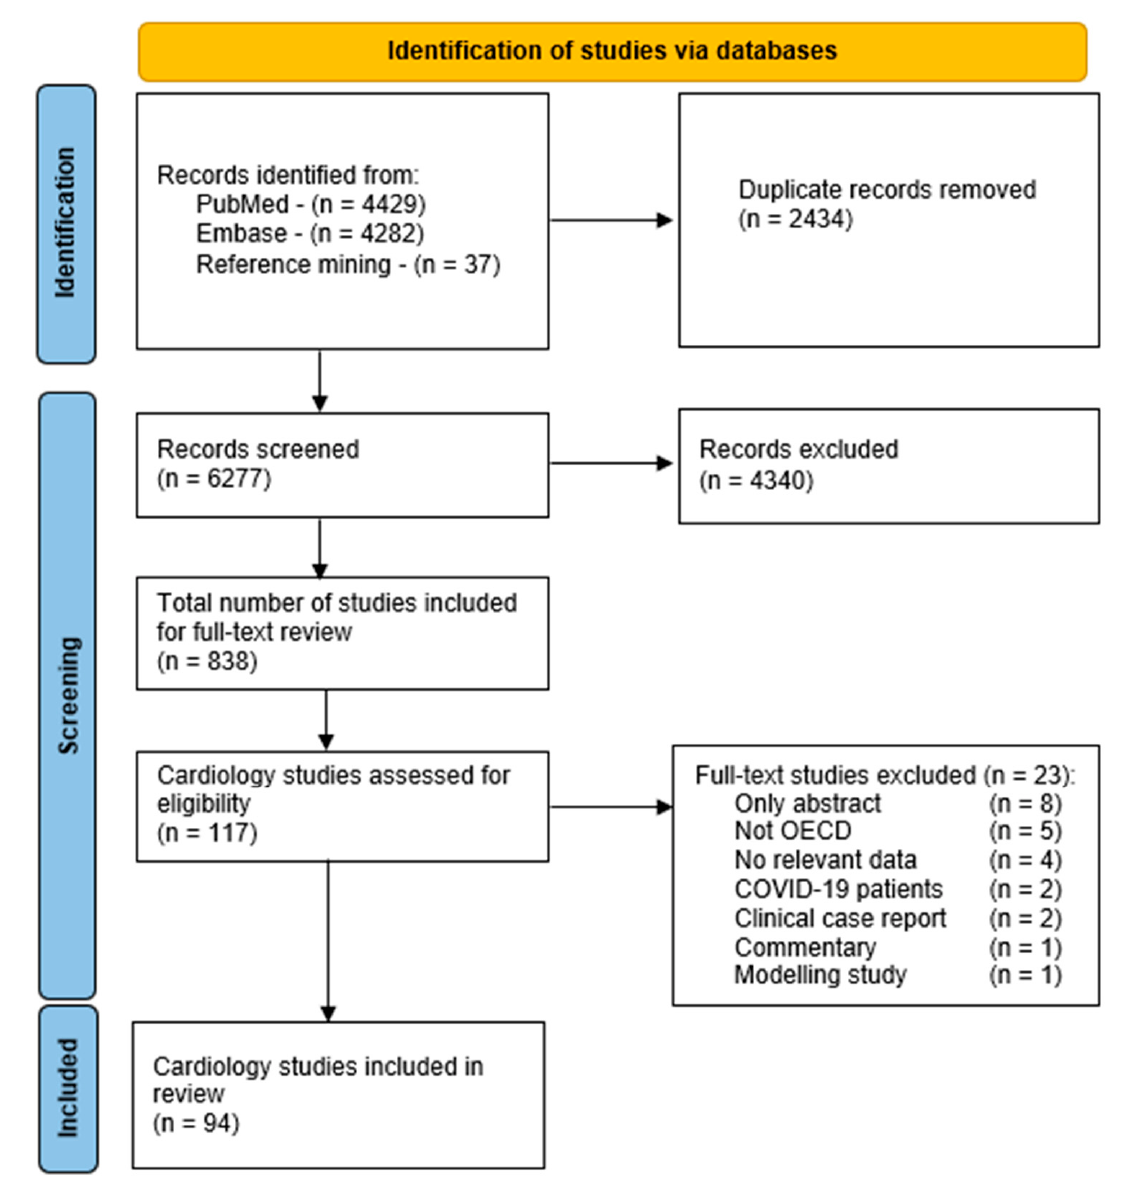
Figure 1. PRISMA flow diagram of the literature search. Abbreviations: OECD—Organization for Economic Co-operation and Development.